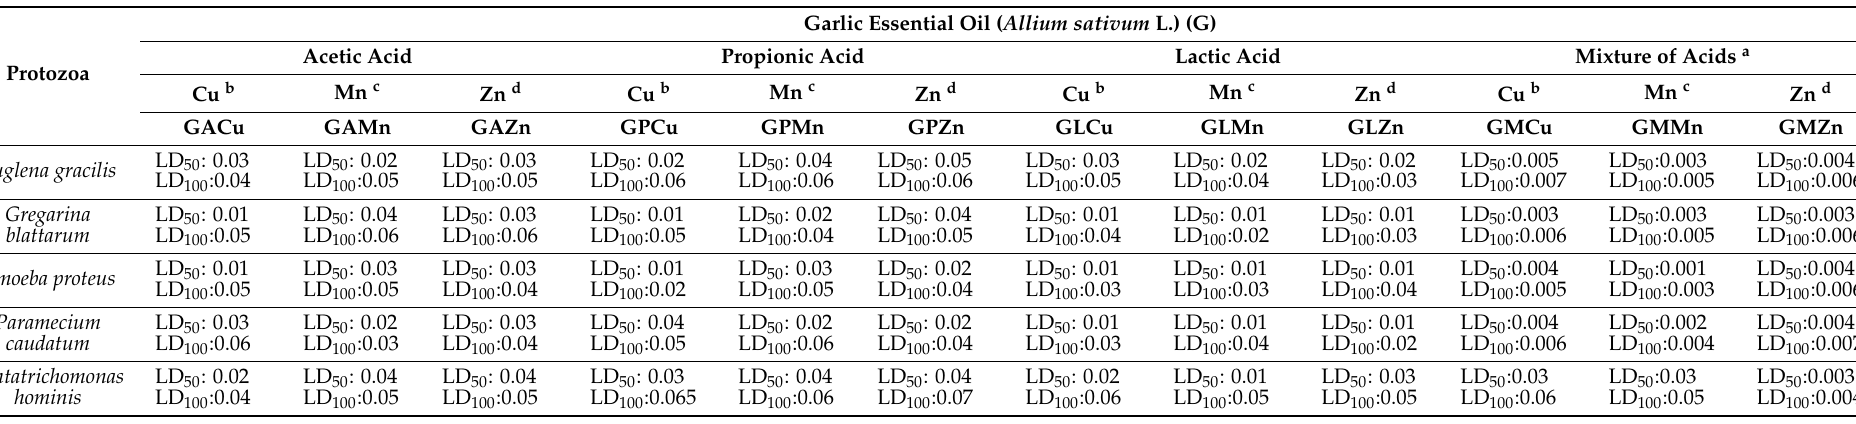
a —chloramphenicol, b —metronidazole, c —in rate 1:1:1, d —Manganese (II) chloride 10% solution, e —Copper (II) carbonate hydroxide 10% solution, f —Zinc carbonate 10% solution, g —5% solution, n.t—not tested. Table 5. LD 50 , LD 100 values [%] for the tested mixtures of garlic essential oil ( Allium sativum L.) (G), organic acids (Acetic acid—A, Propionic acid—P, Lactic acid—L, Mixture of acids—M) and metal ion against selected protozoa. Garlic Essential Oil ( Allium sativum L.) (G) Acetic